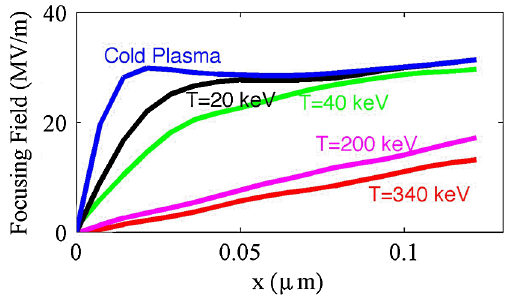
FIG. 4. Radial focusing force on the tail of the drive bunch ( 1 : 25 (cid:2) z from the peak or (cid:7) ¼ 0 (cid:5) m on Fig. 3) for different plasma ion temperatures after 20 cm of plasma. The transverse bunch size is (cid:2) r ¼ 0 : 14 (cid:5) m . The focusing field becomes more linear (closer to the immobile ion case, not shown) with increas- ing ion temperature.